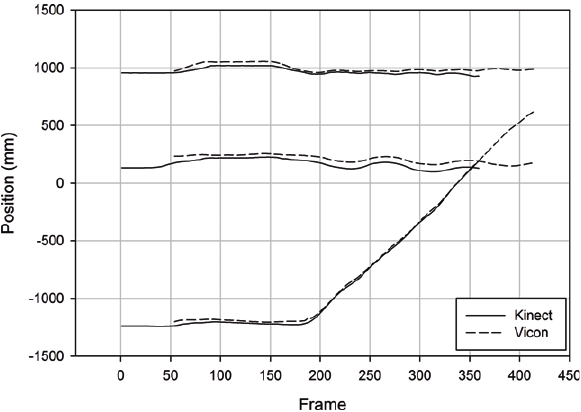
Fig. 5: Graph of center of mass for test 1 ( R 2 x = 0.9999, R 2 y = 0.9766, R 2 z =